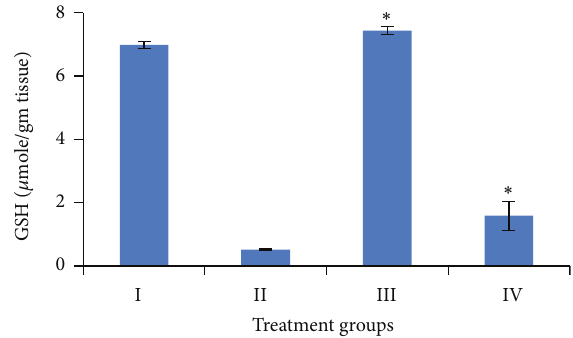
Figure 5: Variations in GSH level after DENA/CCl 4 induced hep- atic carcinogenesis with/without ACE administration. Significance level—normal versus carcinogen treated control; carcinogen treated control versus ACE treated experimental ∗ 𝑃 < 0.001